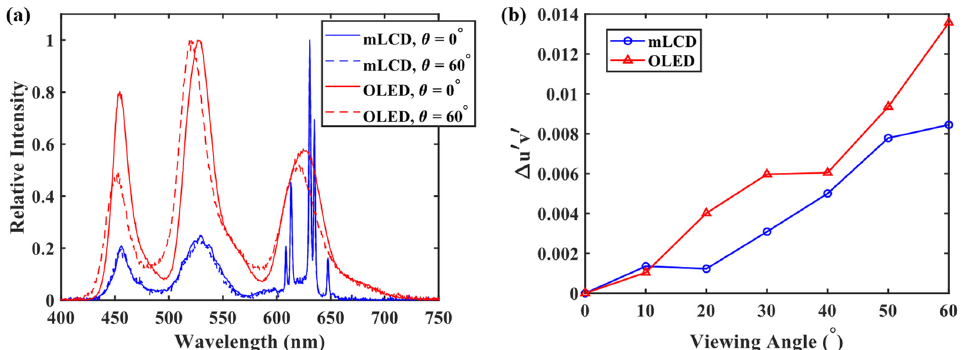
Figure 5. Measured ( a ) white spectra and ( b ) color shifts of the mLCD and the OLED panels.